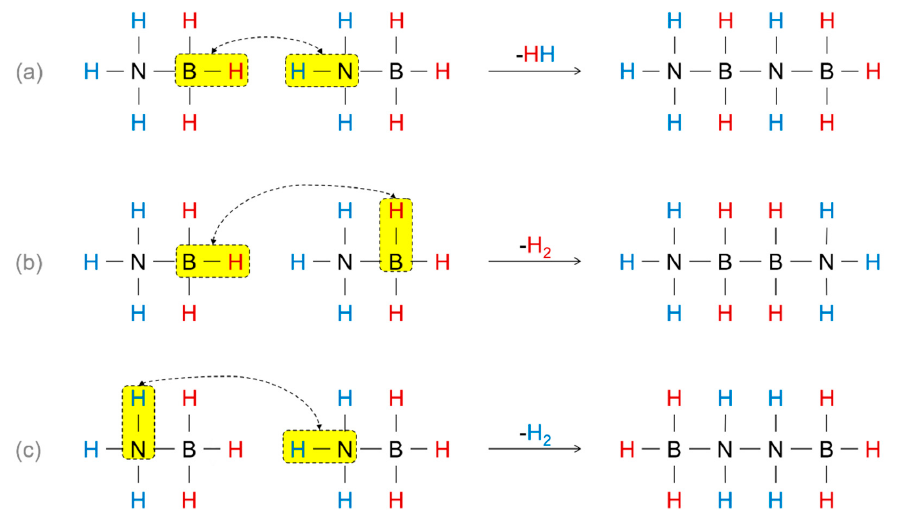
Figure 9. Dehydrocoupling of ammonia borane mediated by ( a ) heteropolar dihydrogen N − H δ + ··· H δ − − B interactions, ( b ) homopolar dihydrogen B − H δ − ··· H δ − − B interactions and ( c ) homopolar dihydrogen N − H δ + ··· H δ + − N interactions.